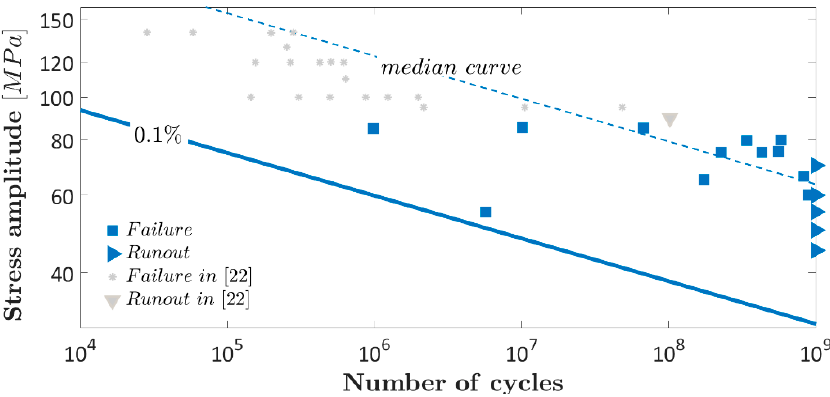
Figure 8. Marginal probabilistic S-N (P-S-N) curve: Median and 0.1%-quantile marginal P-S-N curves.